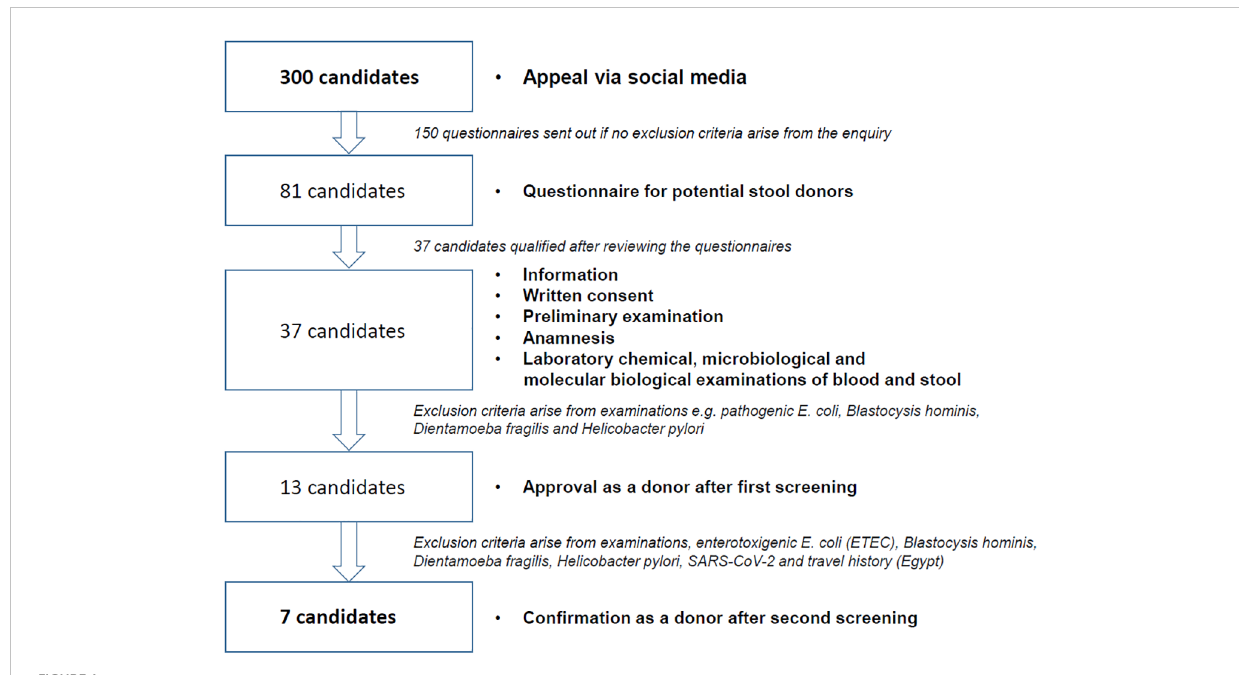
FIGURE 1 Overview of FRESCO trial donor recruitment, selection, and clinical